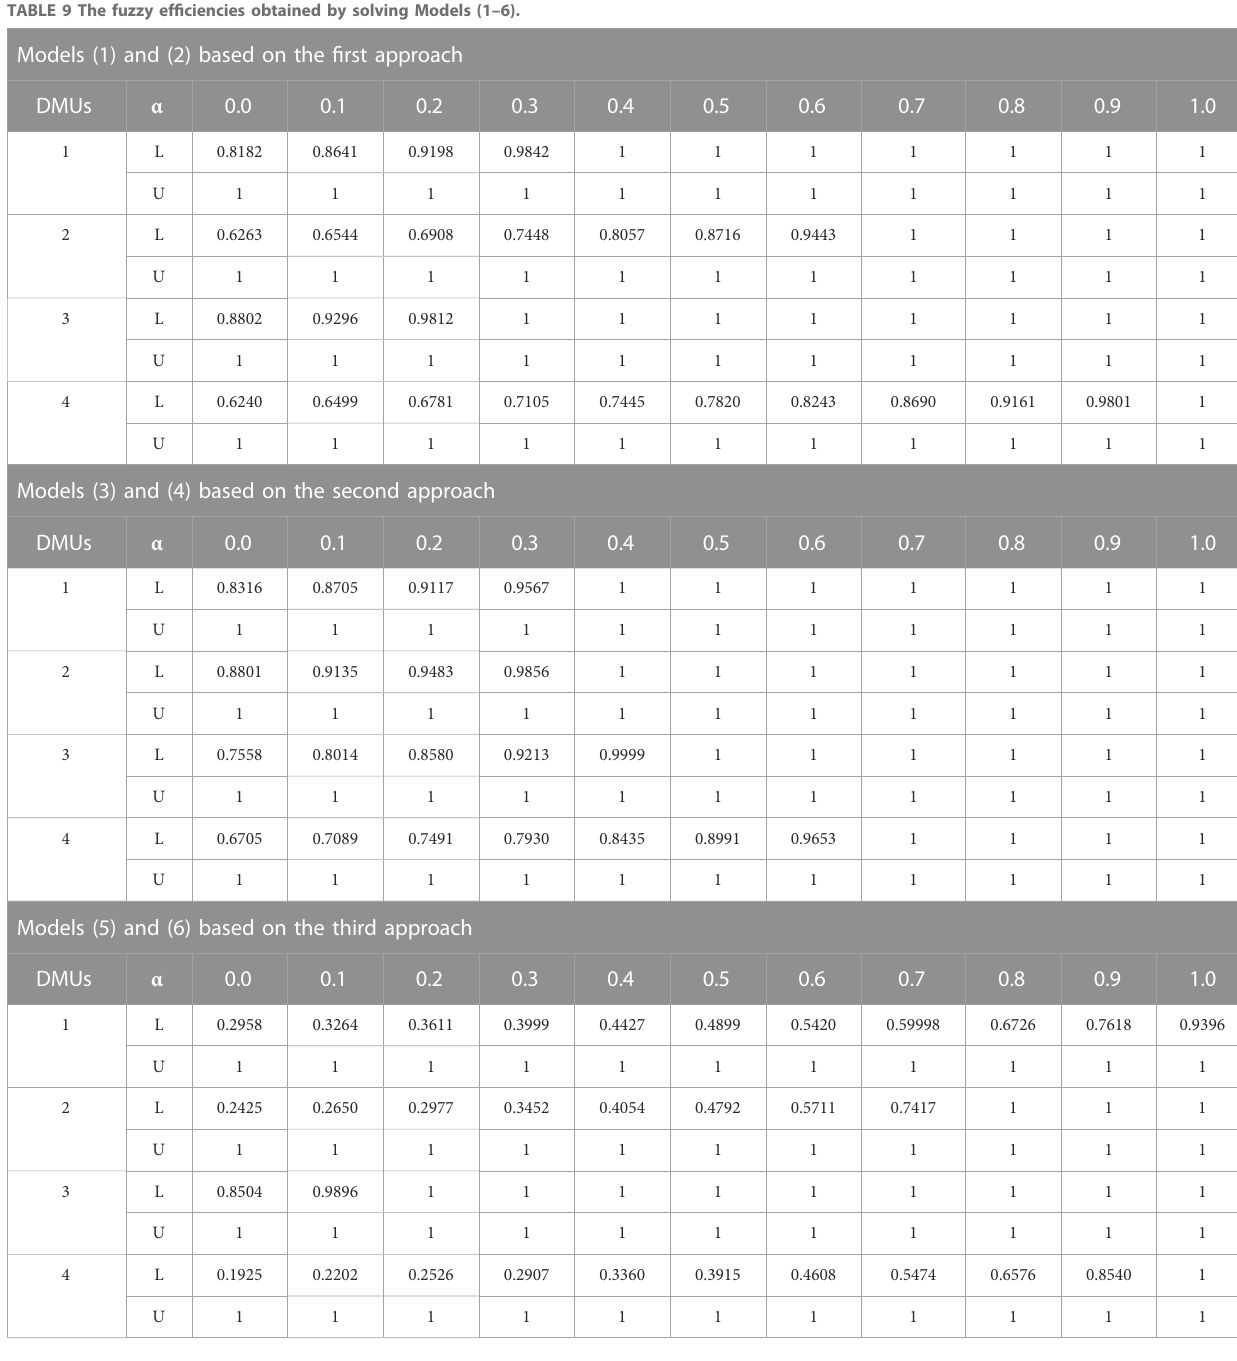
TABLE 9 The fuzzy ef fi ciencies obtained by solving Models (1 – 6). Models (1) and (2) based on the fi rst approach DMUs